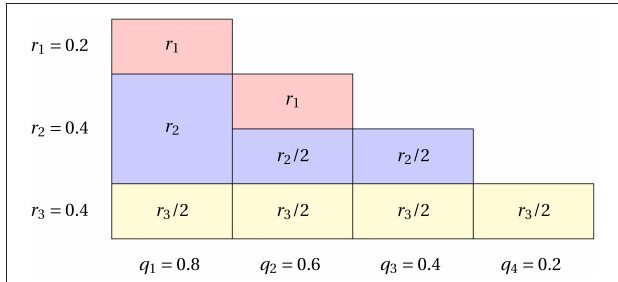
FIGURE 1 | Toy demo illustrating how to obtain a non-uniform mini-batch sampling with batch size b